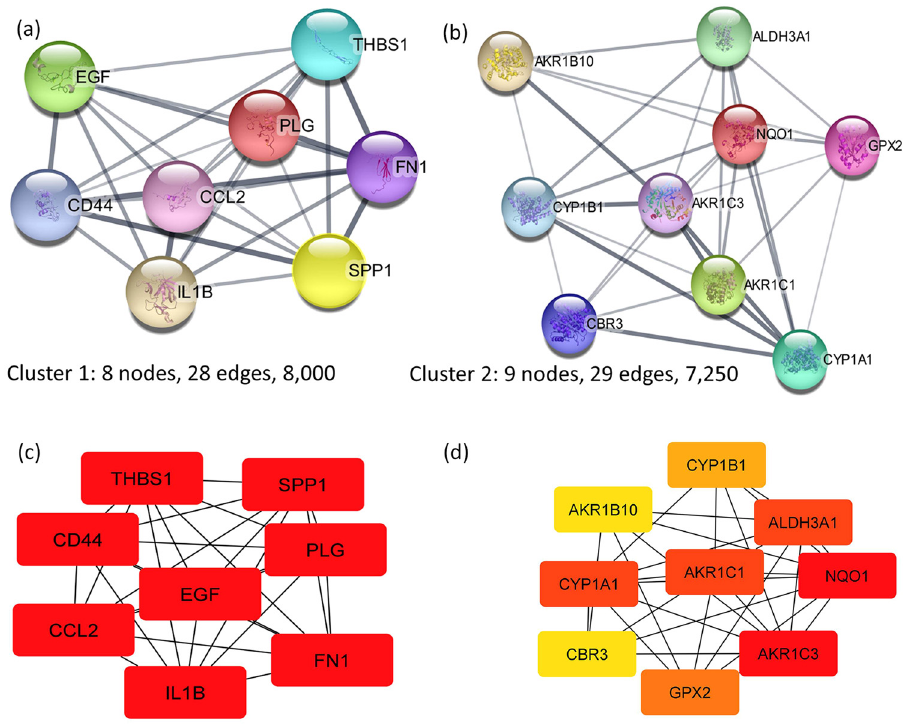
Figure 7: The most important clusters selected from the PPI network ( a ) cluster 1; ( b ) cluster 2. A node in the PPI network denotes a protein and an edge denotes an interaction. The most important genes evaluated in the PPI network using the MCC algorithm in CytoHubba, Cytoscape ( c ) cluster 1; ( d ) cluster 2. The most important genes are ranked as follows: the most important genes are highlighted in red, the less important genes in orange, and even less important genes in